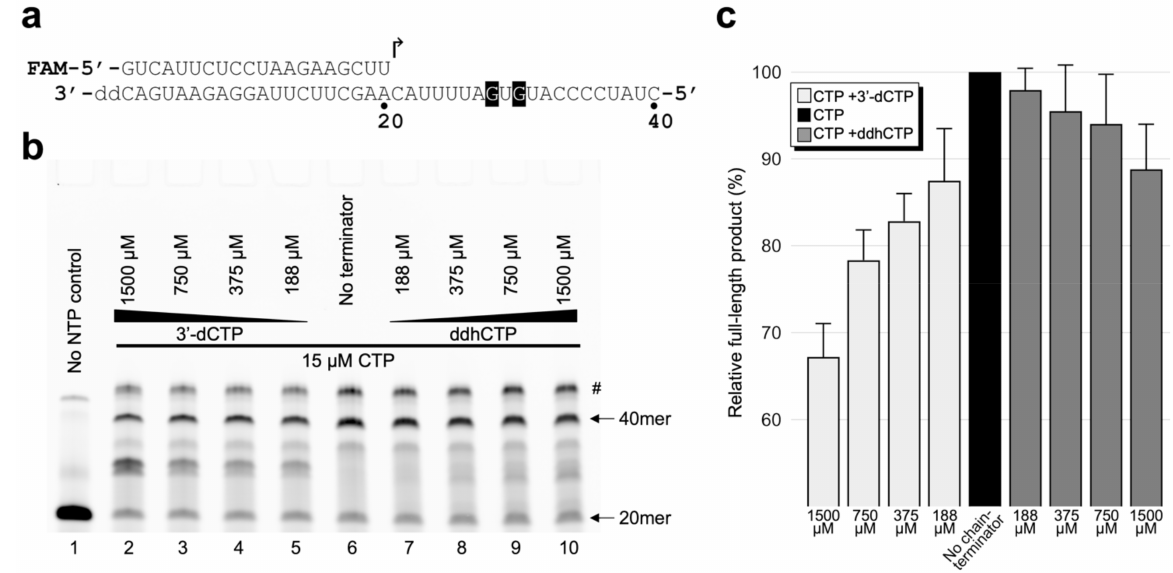
Figure 3. Incorporation of 3 (cid:48) -dCTP or ddhCTP by SARS-CoV-2 RdRp in the presence of CTP. ( a ) Se- quences of the 5 (cid:48) -fluorescein-labeled 20-nt RNA primer and the 3 (cid:48) -protected 40-nt RNA template. The arrow indicates the direction of primer extension. ( b ) Products of primer extension by RdRp in the presence of the indicated concentrations of 3 (cid:48) -dCTP (lanes 2–5) or ddhCTP (lanes 7–10) in addition to 15 µ M CTP. Lane 6 shows extension with no chain terminator. Residual double-stranded form of the fully extended 40-nt product is denoted by #. A representative gel result for 3 independent experiments is shown. ( c ) Quantitation of the gel result in ( b ) and its replicates. Fraction of the fully extended product relative to that for the no-chain terminator control is plotted (see Figure S2 for representative spectrograms). The means +/ − standard deviation ( n = 3) are